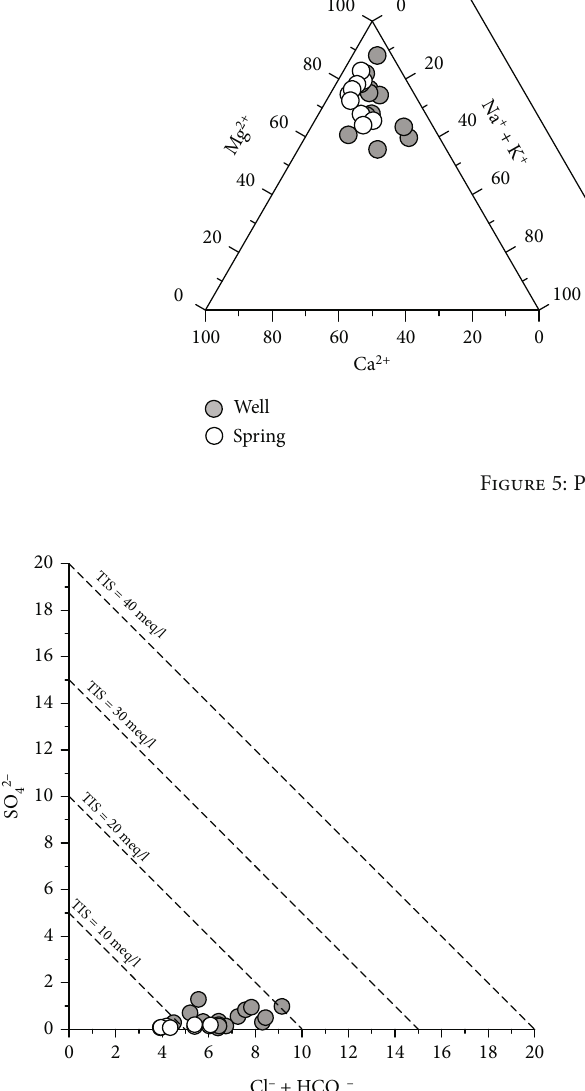
Figure 6: Correlation diagram of SO 42- vs. HCO 3- +Cl - for the water samples. The symbols are as Figure